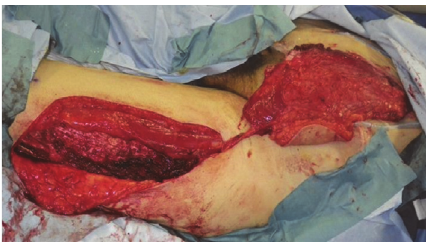
Figure 5: A pedicled vastus lateralis-anterolateral thigh flap was elevated with a motor